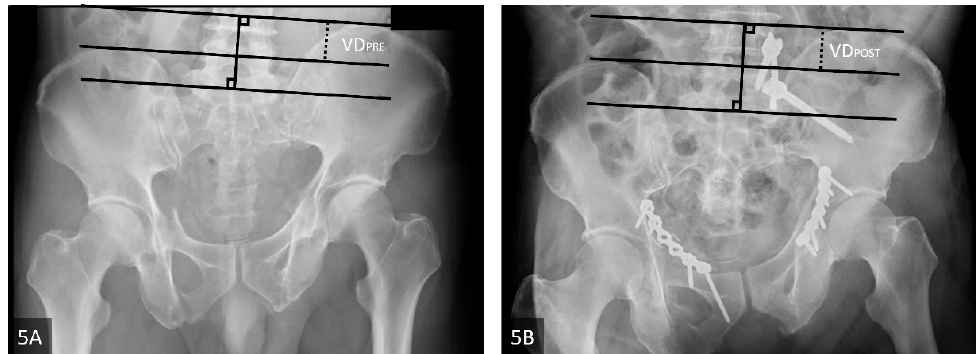
Figure 5. ( A , B ) The absolute displacement method (ADM). The example image illustrated the measurement of vertical displacement in pelvis AP view pre- and post-operatively. ( A ) Pre-operative pelvis AP view. ( B ) Post-operative pelvis AP view. The reference lines are solid, and the measured lines are dashed. The Abbreviations: VDPRE = the pre-operative vertical displacement; VDPOST = the post-operative vertical displacement.